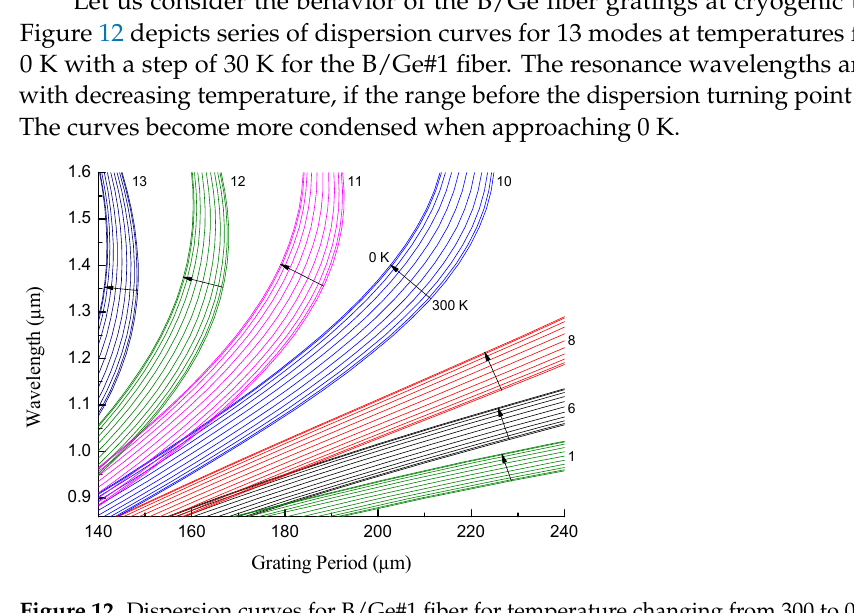
Figure 12. Dispersion curves for B/Ge#1 fiber for temperature changing from 300 to 0 K for cladding mode numbers 𝑗 = 1… 13 .